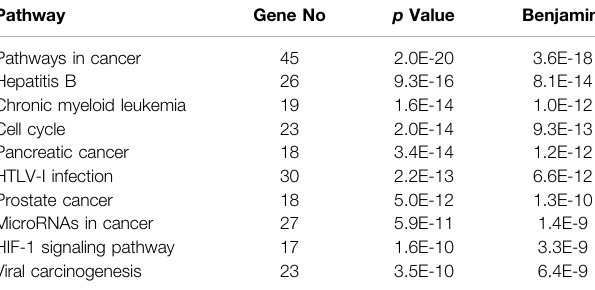
TABLE 4 | GO functional annotation